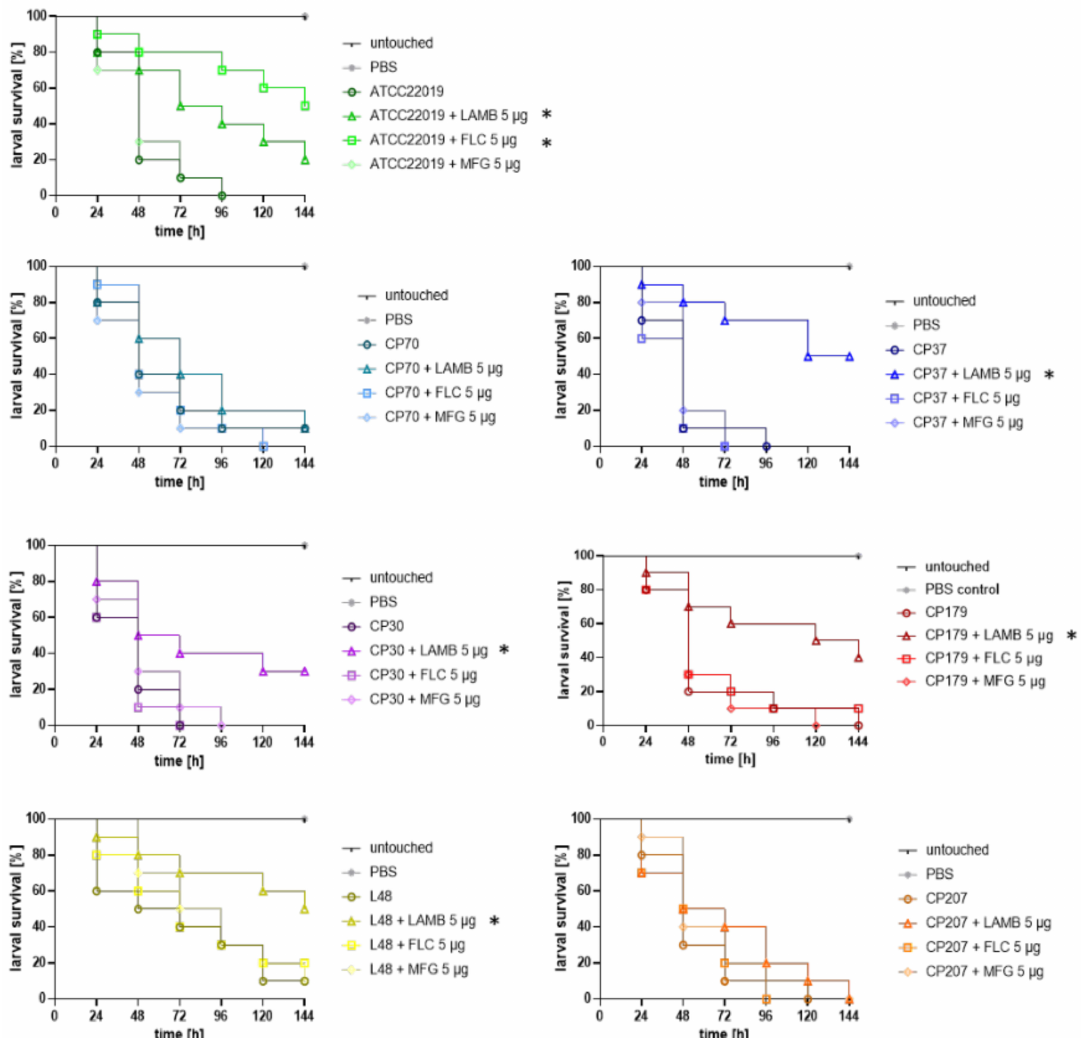
Figure 1. Ability of antifungal drugs to improve survival of G. mellonella larvae infected with C. parapsilosis isolates. All isolates except ATCC22019 showed in vitro resistance against FLC. CP30, CP179, L48 were additionally classified resistant against VRC. CP207 is a multidrug resistant (MDR) isolate with MFG resistance in addition to azole resistance. Larvae were infected with 10 7 cells of the respective strain and treated groups received a single dose of antifungal (LAMB, FLC, or MFG) 2 h post infection (15 mg / kg). Control groups and untreated groups received the same volume of PBS (20 µ L). * Indicates statistical di ff erence ( p < 0.05) according to log-rank (Mantel–Cox test) in comparison to the survival of larvae receiving no antifungal drug. LAMB: liposomal amphotericin B, FLC: fluconazole, MFG: micafungin, VRC: